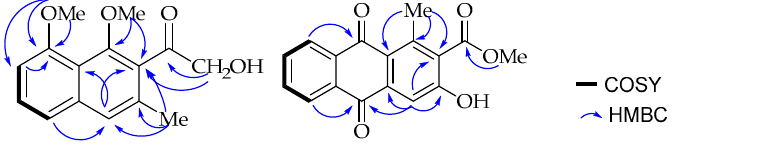
Figure 2. COSY (bold lines) and key HMBC (blue arrows) correlations of 1 and 2 Compound 2 was isolated as yellow solid. The HR-ESI-MS provided a pseudomolecular ion peak at m / z 297.0753 [M + H] + , corresponding to the molecular formula of C 17 H 12 O 5 . The UV spectrum ( λ max 264, 298, 336, 371 nm) and NMR spectra suggested an anthraquinone skeleton [23]. The